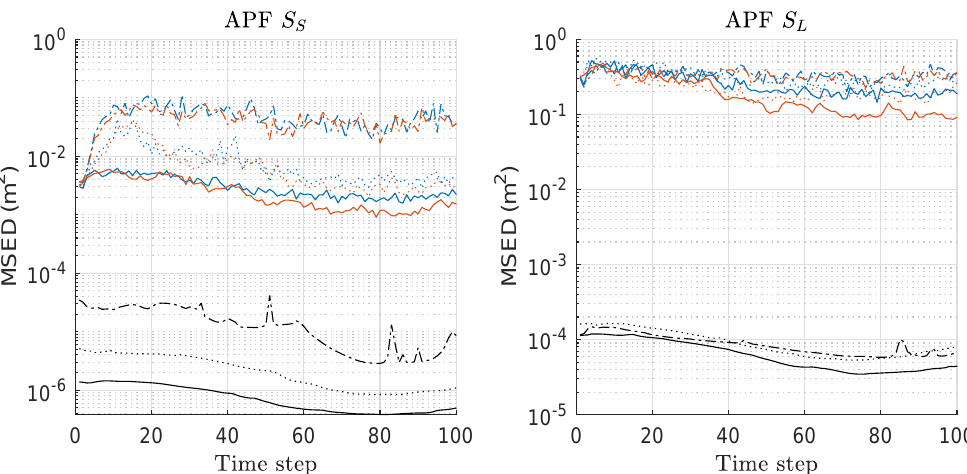
Figure 4. Mean square error of distance (MSED) performance comparison between auxiliary-PF (APF) and minimax APF (MAPF). Three hundred runs were performed with 1000 particles, where M , S S , S L denote the number of sensors, the scenario of the small state noise variance, the scenario of the large state noise variance, respectively. Comparison with Cramér-Rao lower bound was also shown, as derived in the Appendix A. Legend: line style (dash-dot: M = 2; dotted: M = 5; solid: M = 10); (line color: blue: APF; red: MAPF; black: CRB).